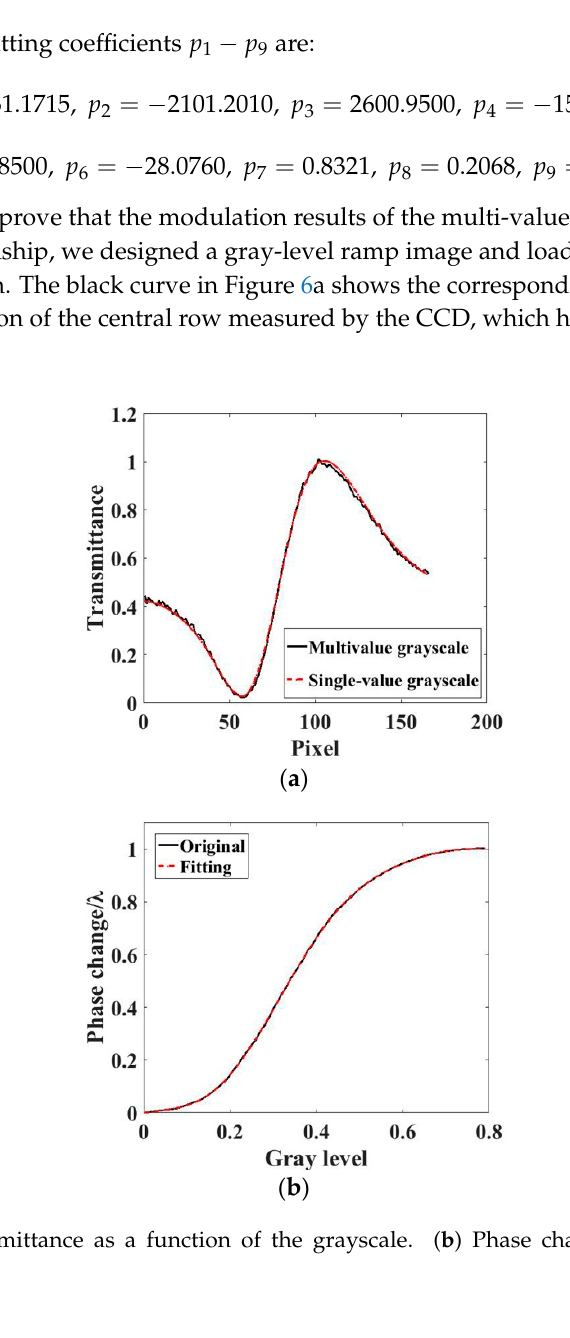
Figure 5. Optical setup used to measure the modulated wave-front. 1, 1053 nm continuous-wave Laser; 2, expander; 3, polarizer; 4, OASLM; 5, lens1, f1 = 150 mm; 6, lens2, f2 = 100 mm; 7, partially reflective mirror; 8, analyzer; 9, filter; 10, CCD; 11, filter; 12, wave-front sensor (WFS) (Physics Co., France, the spatial resolution is 29.6 µ m).